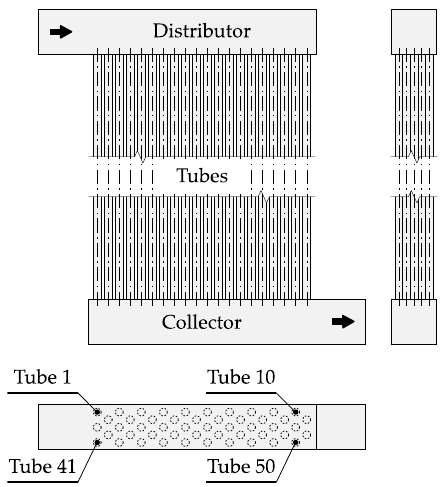
Figure 1. Schematic of the flow distribution system from Table 1.